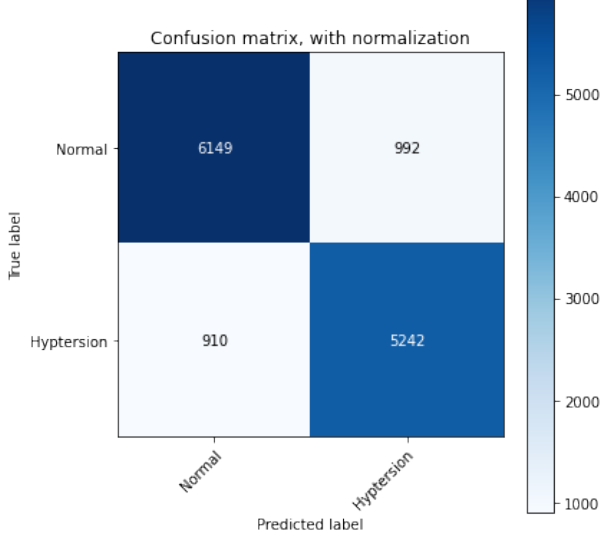
Figure 11. Confusion matrix obtained for the proposed